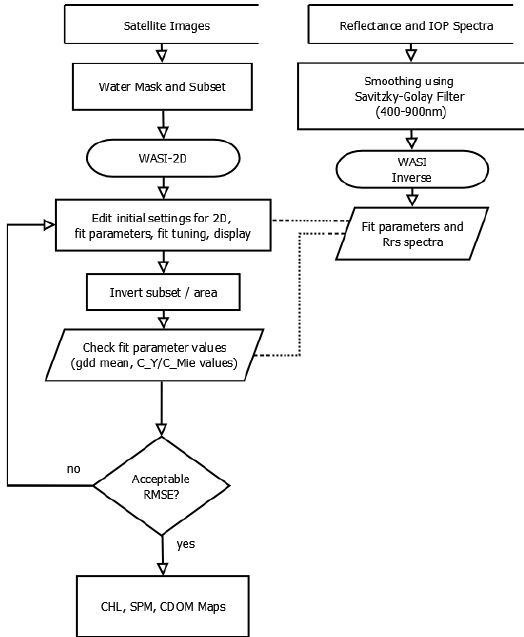
Figure 4. Workflow for the inversion using WASI